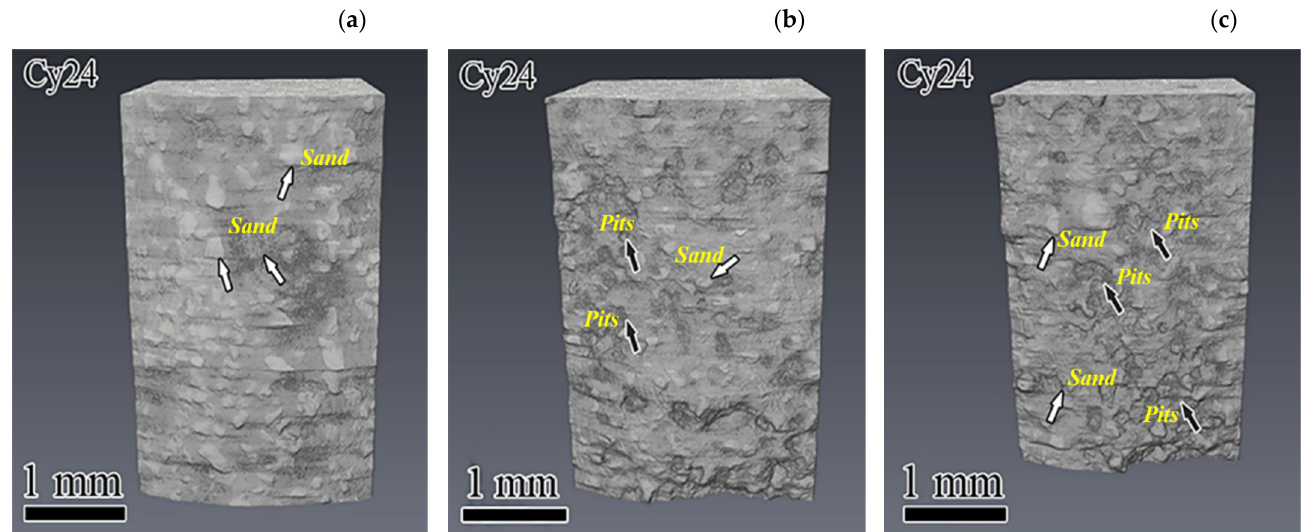
Figure 6. Reconstructed 3D image of the three specimens after different drying–immersion cycles: ( a ) Sc; ( b ) Ss; ( c ) Scs.